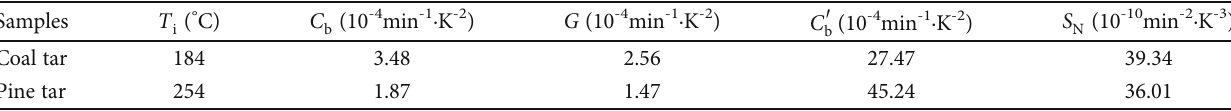
Table 4: Combustion characteristic index of test samples.